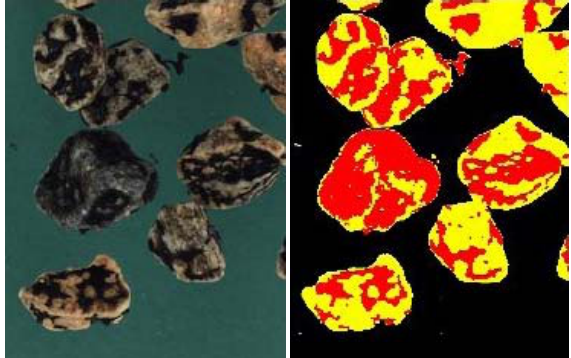
Figure 3: Original image (left) and classification result (right) (Morgenstern et. al.,